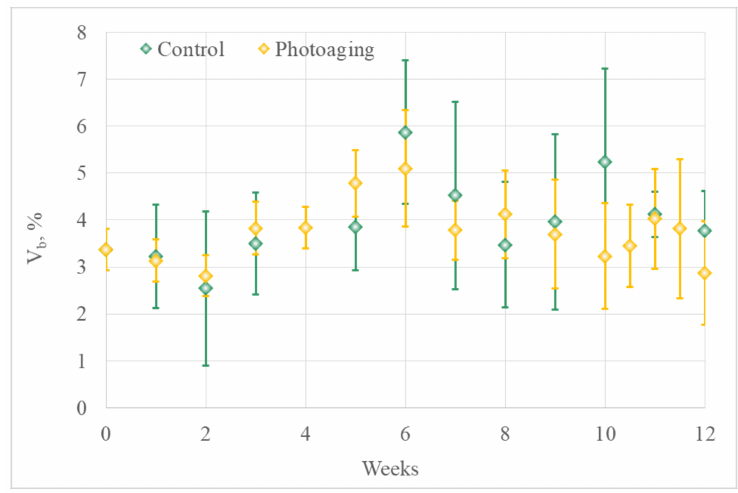
Figure A6. Dynamics of mean values of relative volume of total hemoglobin in a tested tissue’s volume ( V b ). Standard deviations are